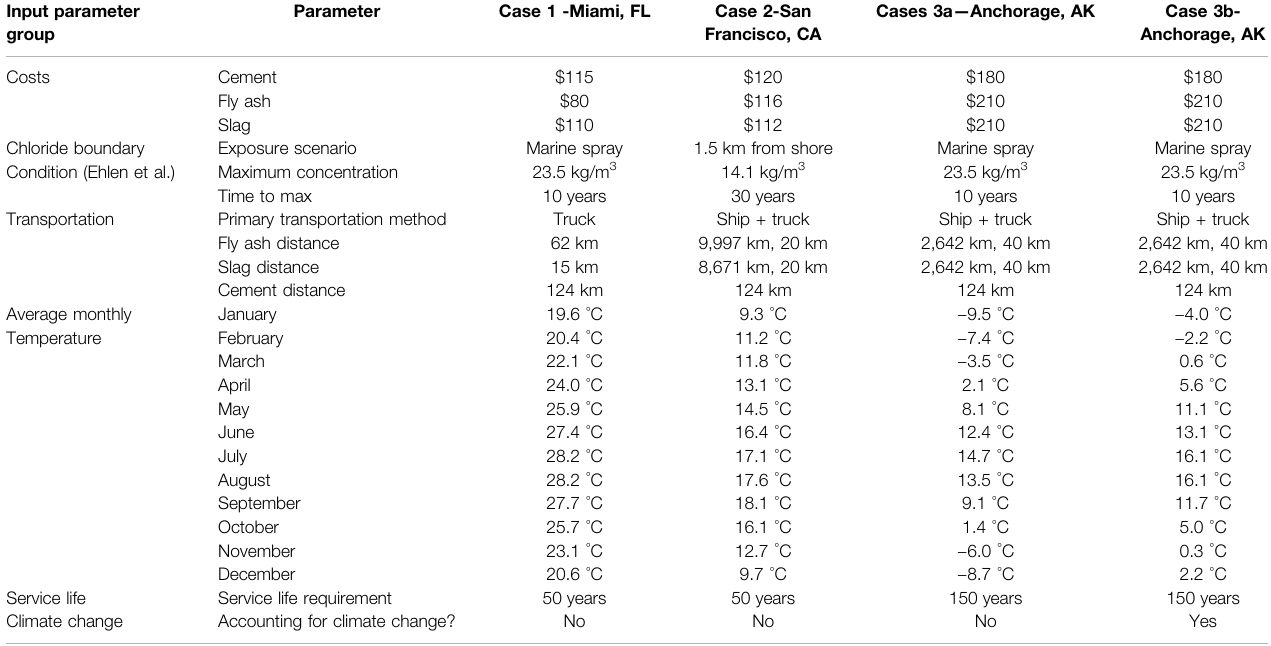
TABLE 5 | Summary of input parameters speci fi c to each case study.